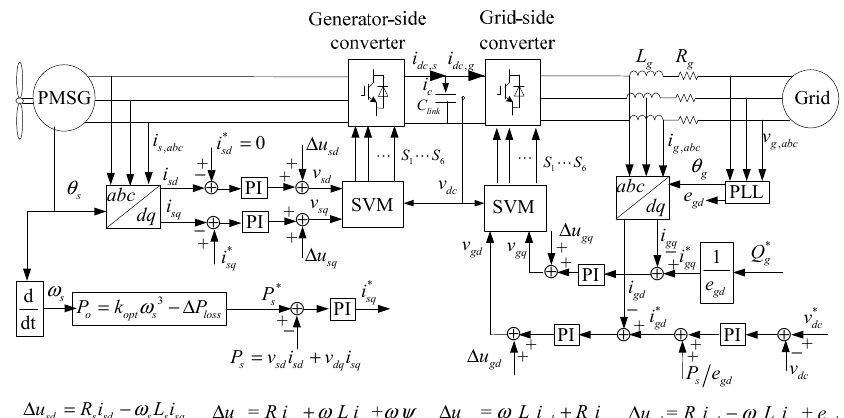
(Pulse-Width Modulation) converter. The back-to-back PWM converter consists of a generator-side converter, DC-link capacity and a grid-side converter.